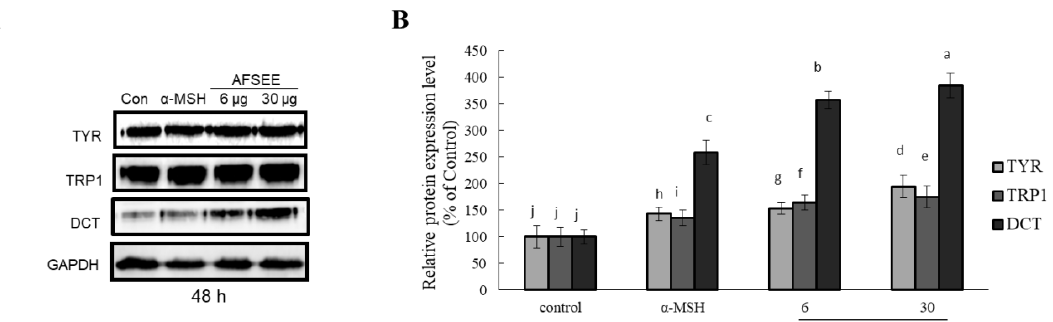
Figure 3. E ff ect of argan fruit shell ethanol extract (AFSEE) on the expression level of the melanogenic enzymes tyrosinase (TYR), tyrosinase-related protein 1 (TRP1), and dopachrome tautomerase (DCT). ( A ) The expression level of TYR, TRP1, and DCT was determined by Western blotting. B16F10 cells were cultured in a 100 mm dish at a density of 3 × 10 5 cells / dish, and treated without (control) or with α -MSH (200 mM) or AFSEE (6 µ g / mL and 30 µ g / mL) for 48 h. ( B ) The protein band intensities of TYR, TRP1, and DCT were obtained using Li-COR Software. Data were subjected to ANOVA ( n = 3). All comparisons were made between treatments. Di ff erent letters indicate treatment di ff erences at the p ≤ 0.05 level.